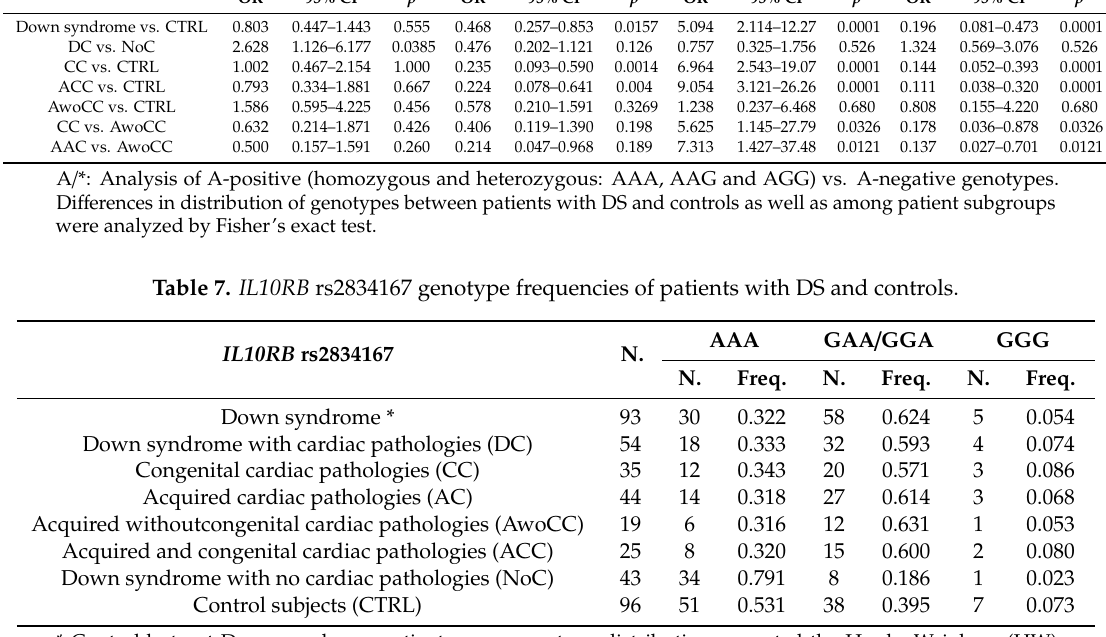
Table 6. Statistical analyses of di ff erences in genotype frequencies between Down syndrome patients and control groups. IFNGR2 rs2834213